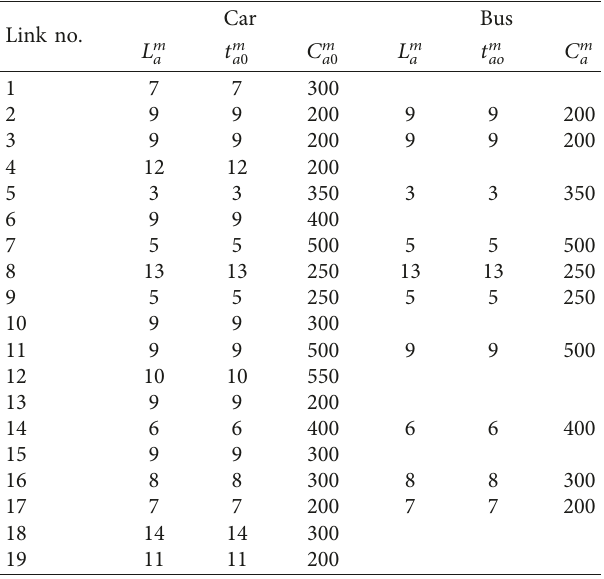
Table 4: Characteristics of link.